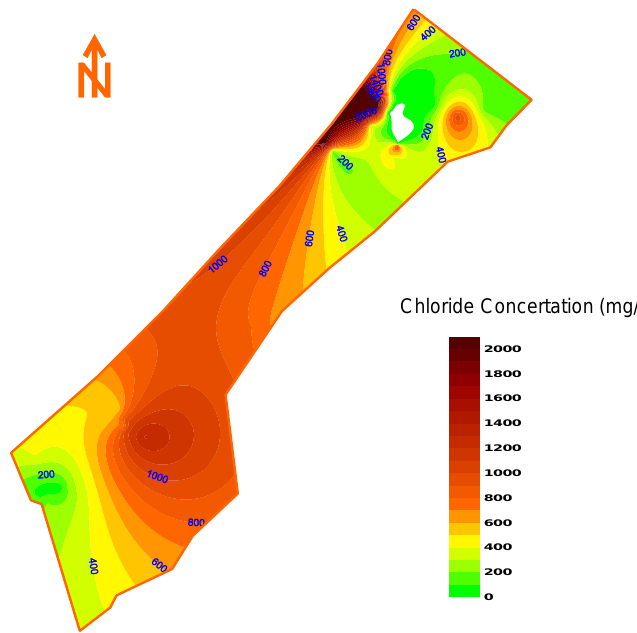
Figure 9. Predicted chloride concentration in 2030 for scenario 2.